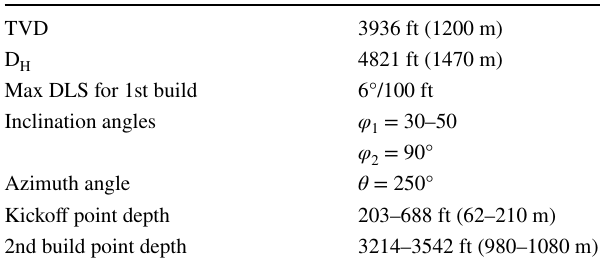
Table 1 Constraints applied to the example well path (Case 1—off- shore